Question: What type of chart is this?
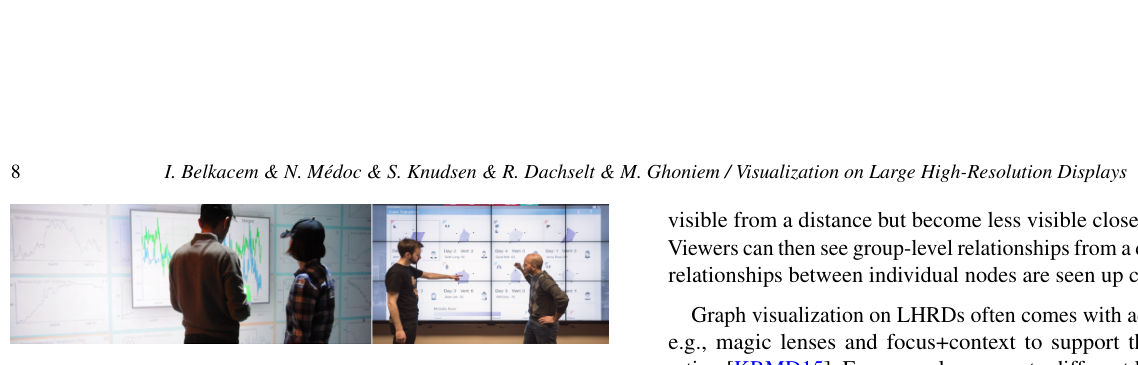
Answer: line